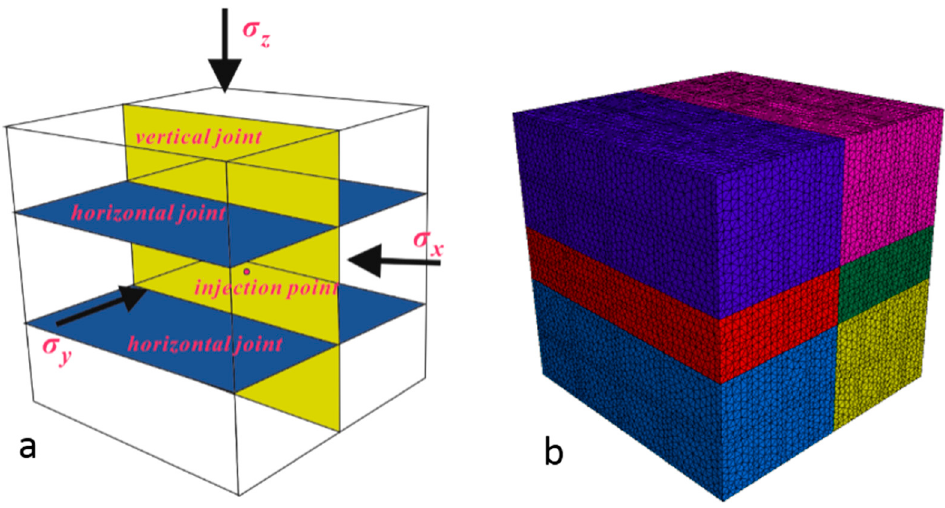
Table 1. Values of parameters for simulation [25].